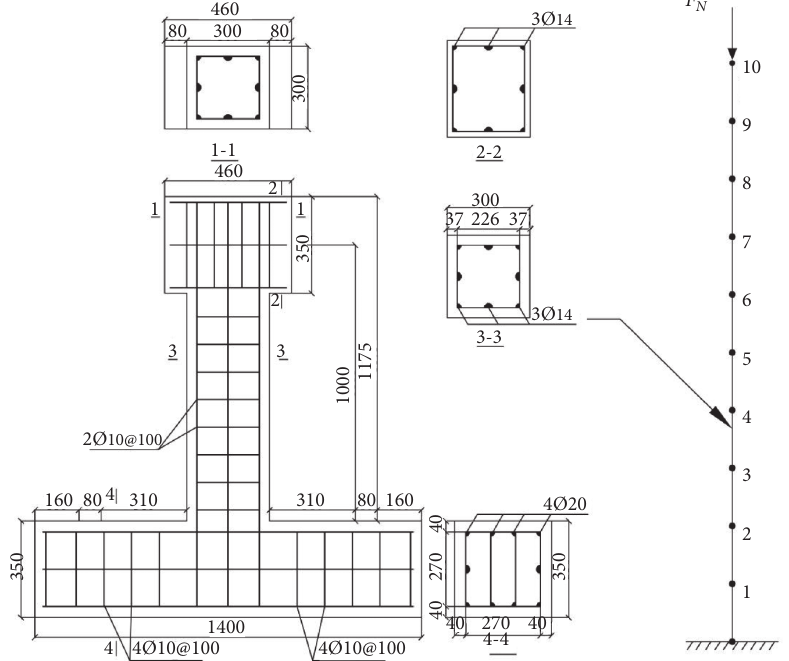
Figure 2: Blueprint and simplified model of the specimen.